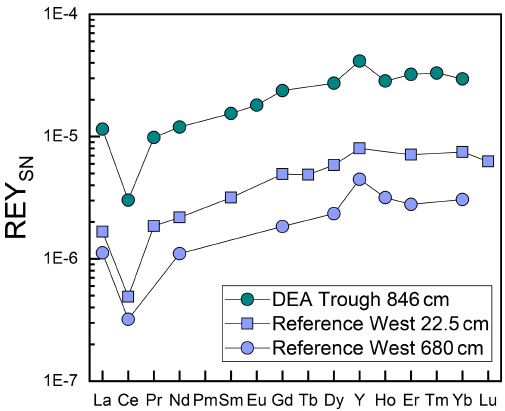
Figure 10. Measurable porewater REY SN patterns from the Peru